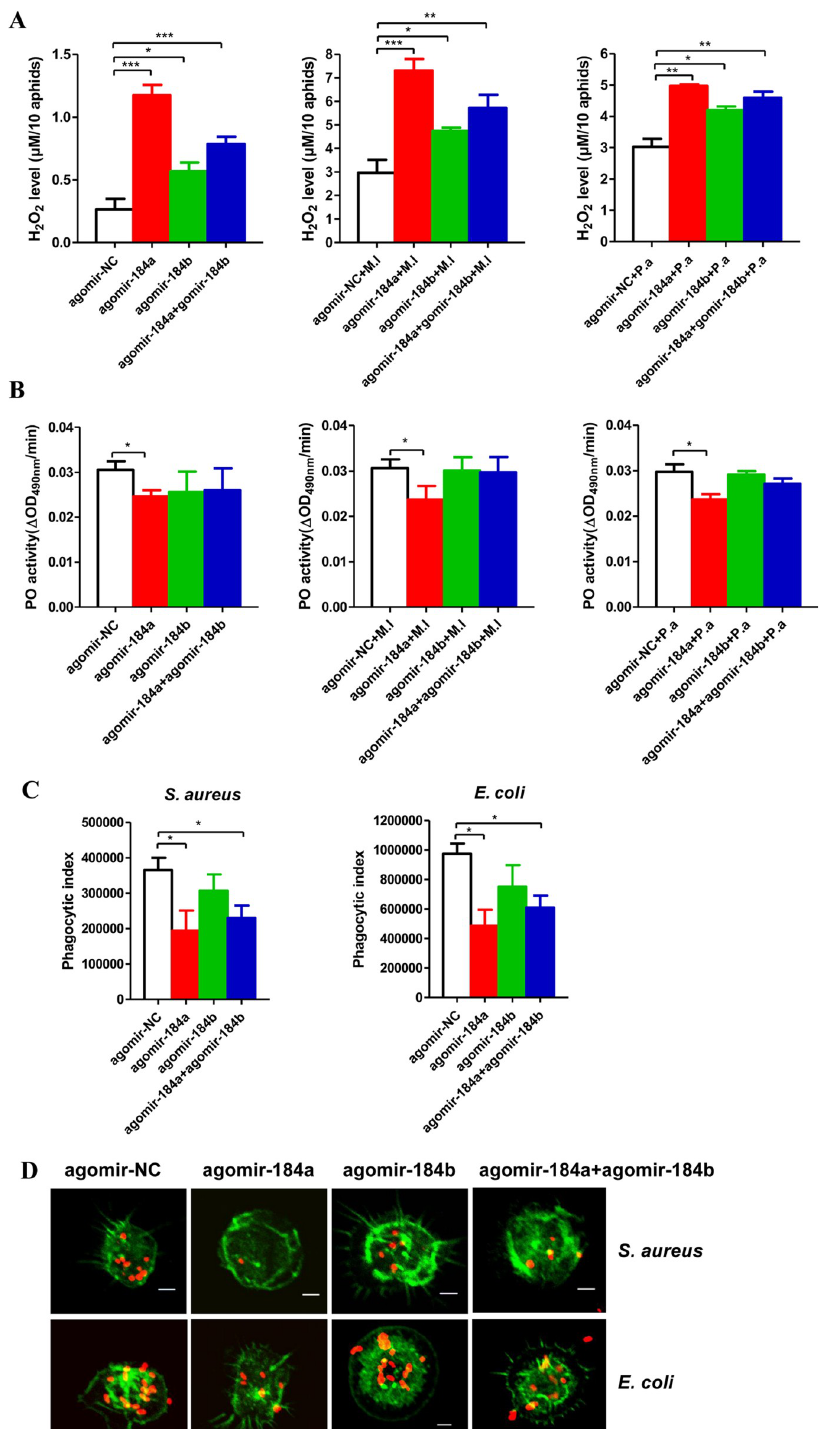
Fig 6. miR-184a/b regulate ROS metabolism, PO activity and hemocytes phagocytosis. Effect of injection of agomir-184a, agomir-184b and half-dose agomir-184a plus half-dose agomir-184b on H 2 O 2 concentration (A) and the PO activity (B) in the aphids uninfected and infected by M . luteus (M.l) and P . aeruginosa (P.a) and the hemocytes phagocytosis (C-D) . Ten aphids for the sample per group at each time point were used for the measurements of H 2 O 2 concentration. Twenty aphids for the sample per group at each time point were used for measurements of PO activity. The hemocytes from 20 pea aphids per group were used to perform each experiment. For (A-C) , the values shown are the mean ( ± SEM) of three independent experiments and the statistical differences between the compared groups were